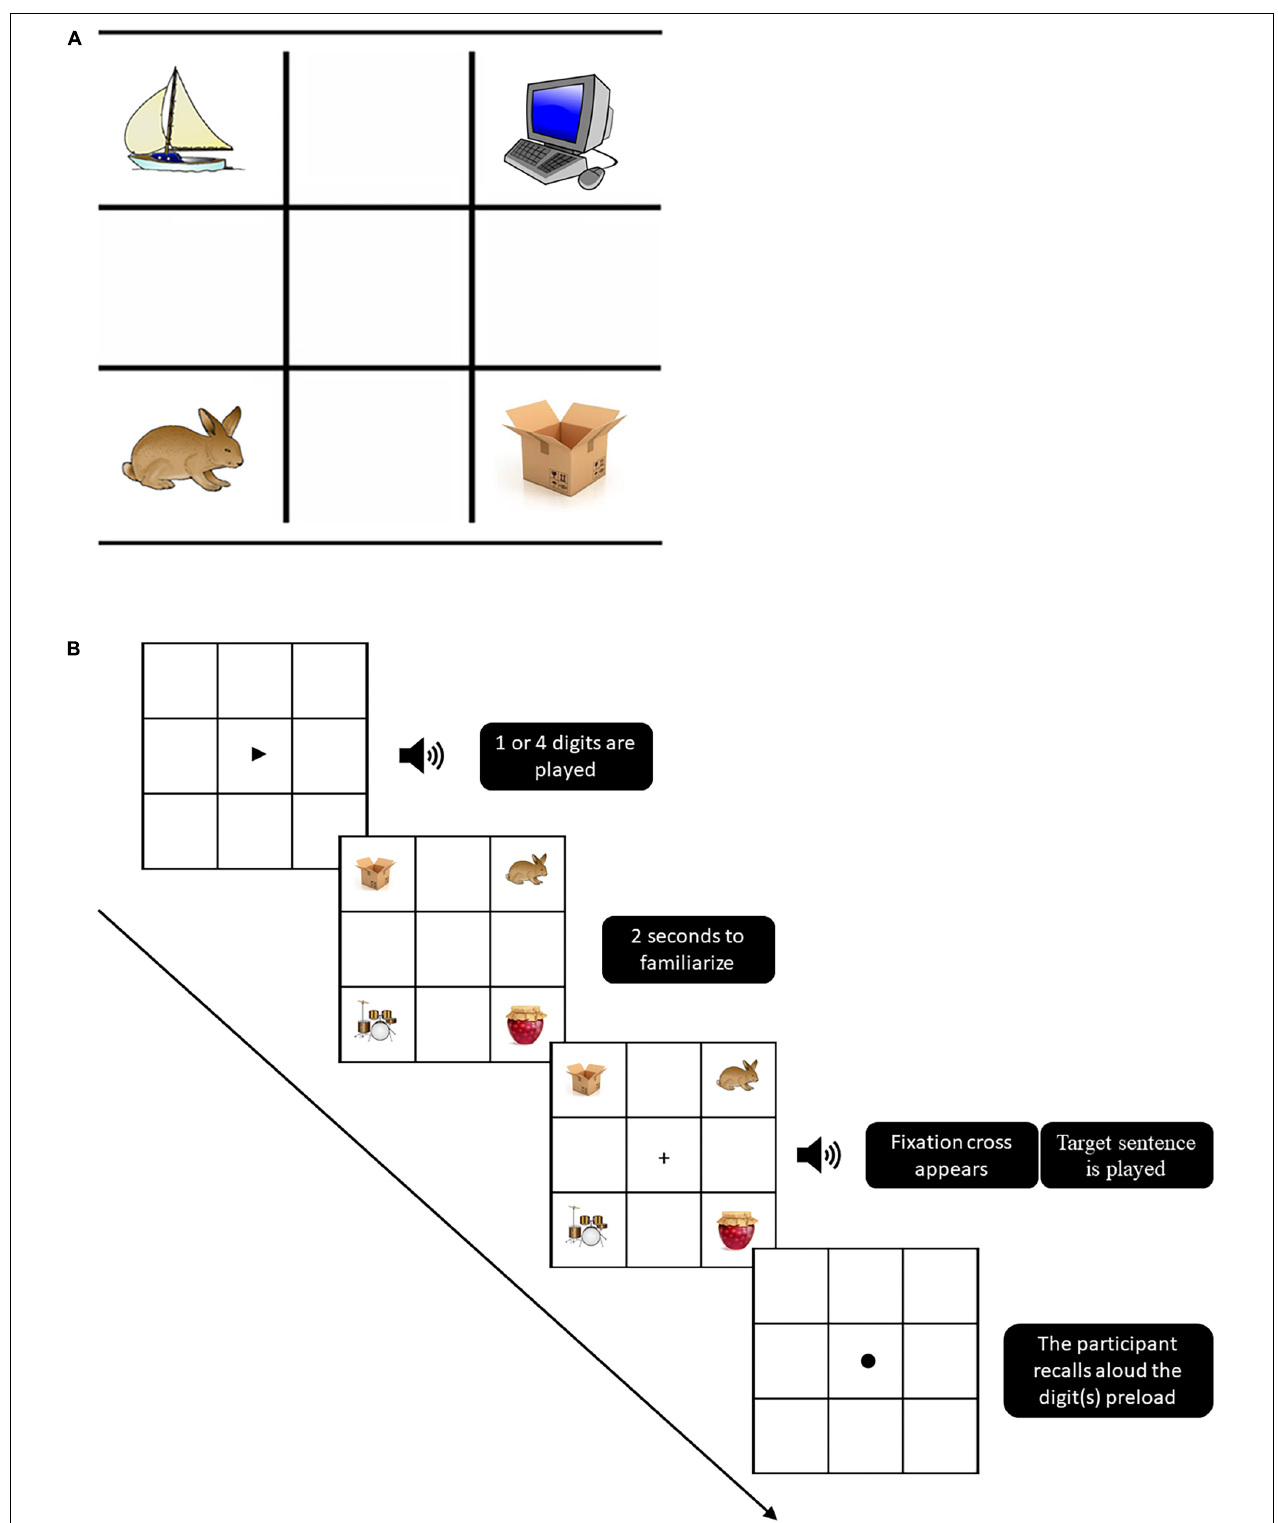
FIGURE 1 | (A) Example of an experimental display in Hebrew: the target word, /a .nav/ (rabbit), is represented in the bottom left corner. The onset phonological competitor /a .gaz/ (box), is represented in the bottom right corner. /si. a/ and /max. S ev/ (boat and computer, respectively) are unrelated distractors. (B) Experimental task design: the sequence of displays presented in each